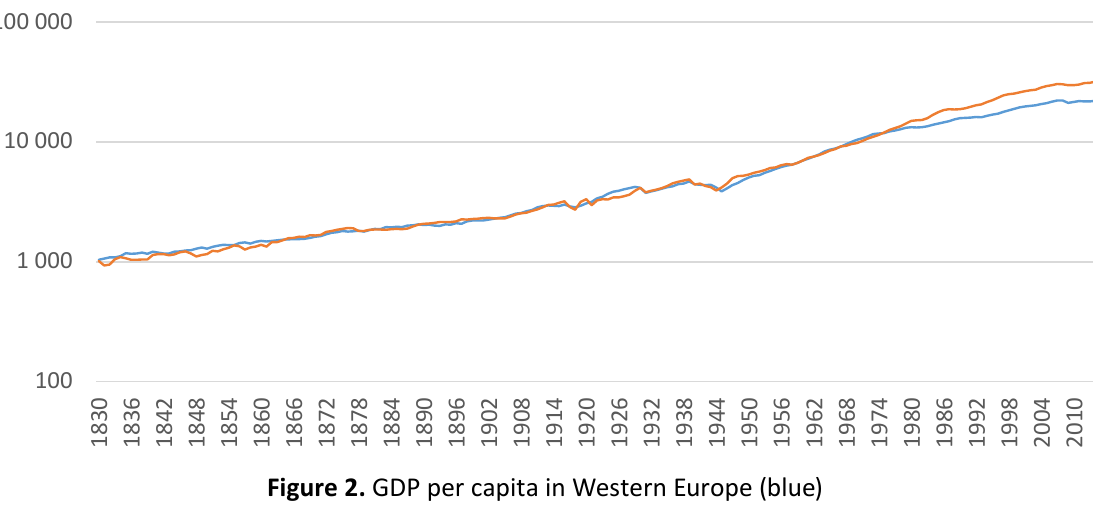
Figure 2. GDP per capita in Western Europe (blue) and Norway (red) for 1830–2015 in 2002, US$